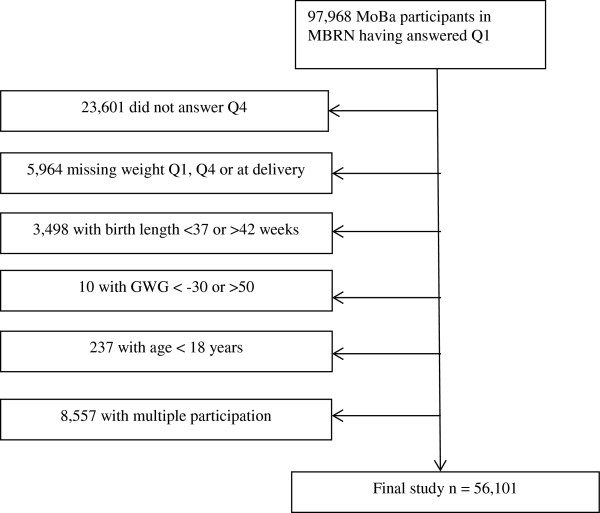
Flow diagram for inclusion of participants for the study from the Norwegian mother and child cohort.